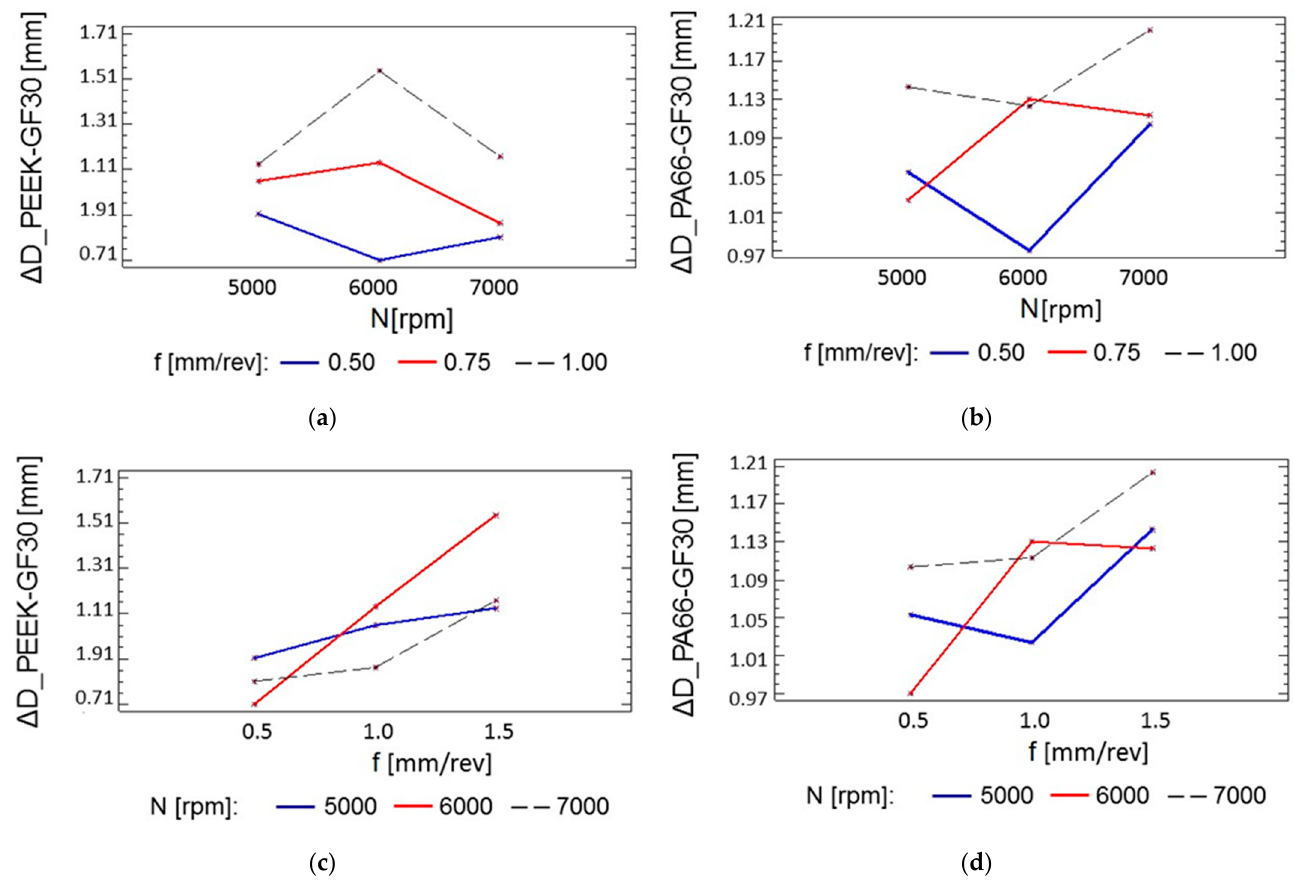
Figure 7. Interaction plots for diameter variation: ( a ) for Δ D_PEEK-GF30 and N; ( b ) for Δ D_PA66-GF30 and N; ( c ) for Δ D_PEEK-GF30 and f; and ( d ) for Δ D_PA66-GF30 and f.